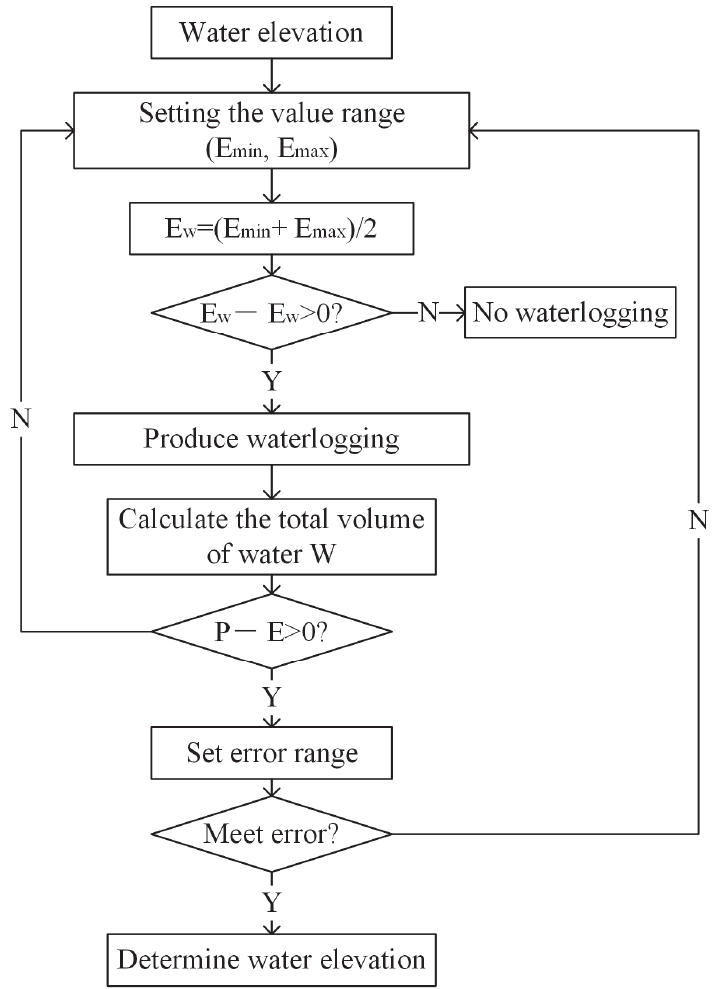
Figure 4. Flow chart of the local equal volume algorithm.